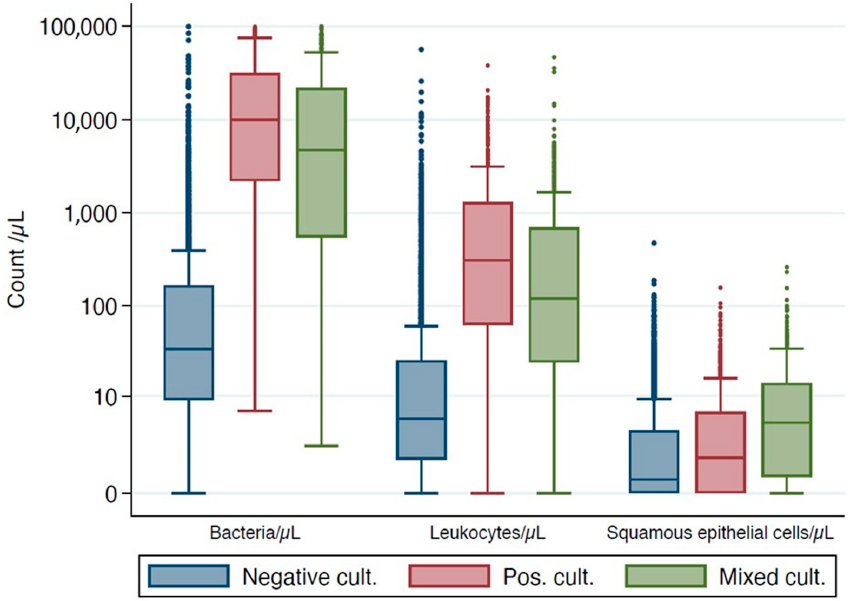
Figure 2. Boxplot diagrams of different UFC parameters according to the type of urine culture growth. 3.3. Prediction of Mixed Culture and the Role of Squamous Epithelial Cells (Two-Class Classifi-